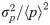
Single cell gene expression histogram and trajectories for AHL = 50 nM.(A) Evolution of the bacterial fluorescence per area F/A as a function of time. Clusters of ‘late inducers’ are visible. (B) Histogram of F/A at time t = 600 min using a logarithmic scale on the x-axis. Solid lines represent the two Gaussian distributions resulting from the Gaussian mixture fitting procedure used to separate out the dominant, homogeneous fraction of cells. (C) Parametric plot of the square of the coefficient of variation (CV) of p = F/A, i.e., σp2/〈p〉2, as a function of 〈p〉. The noise is dynamically ramping up until the cells reach roughly 1/3 of their maximal expression level. After this, CV2 stays approximately constant, indicating the dominance of extrinsic noise in gene expression.